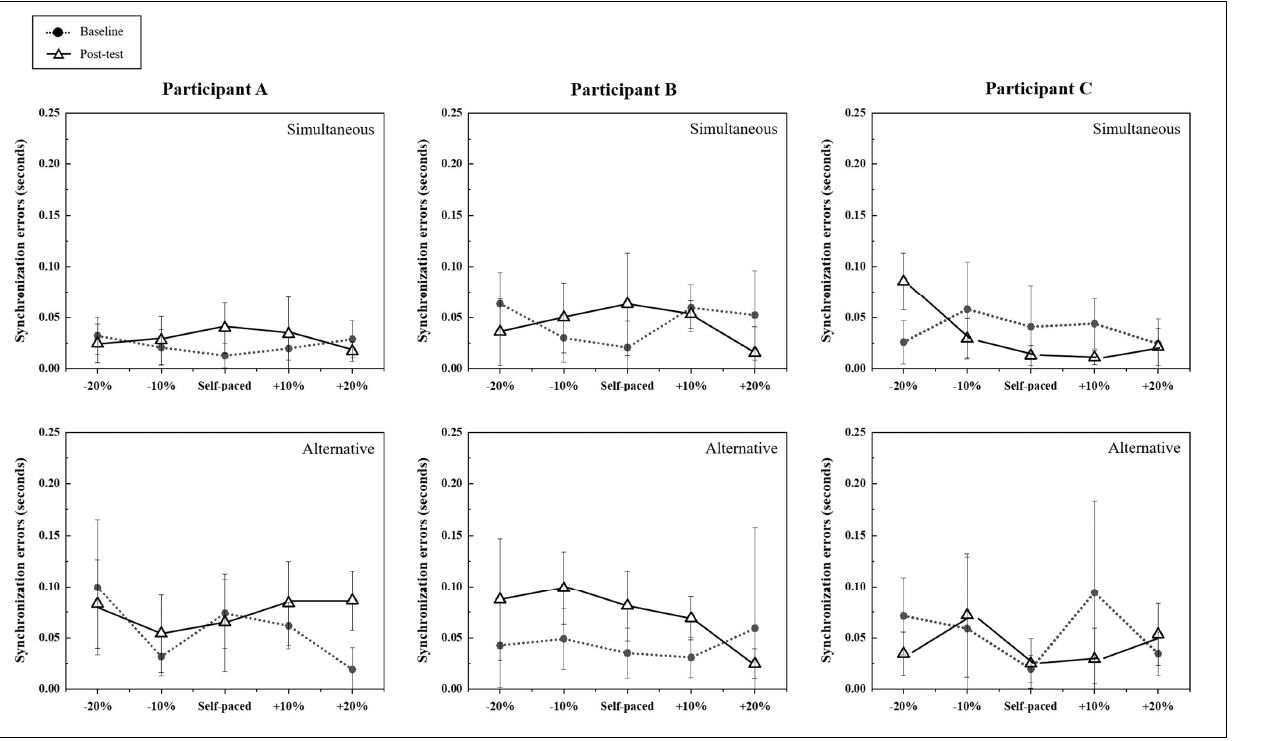
Figure 2. Changes in synchronization errors for the bimanual drum tapping task. The mean synchronization errors during bimanual tapping across the five conditions (self-paced, +10% tempo, +20% tempo, −10% tempo, and −20% tempo) were measured pre- and post-intervention for each partic- ipant.